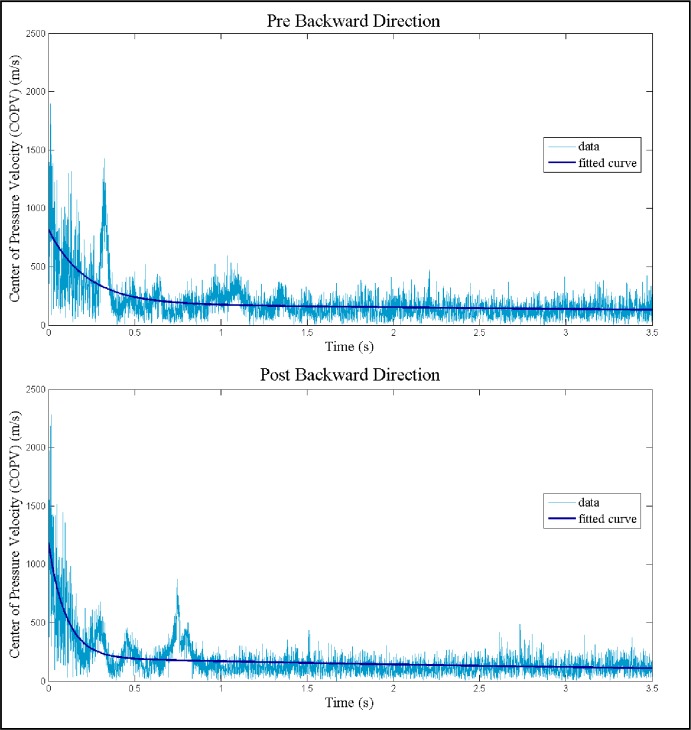
Center of pressure velocity decay.A typical example of exponential fits to the center of pressure velocity (COPV) before and after the TBP for participant 8. A stronger GBM is demonstrated in the Post-TBP backwards direction (lower graph) with a sharper deceleration. Pre-TBP and Post-TBP GBM values for these graphs equal -4.72 and -9.99, respectively; indicating faster stabilization from dynamic to static balance.